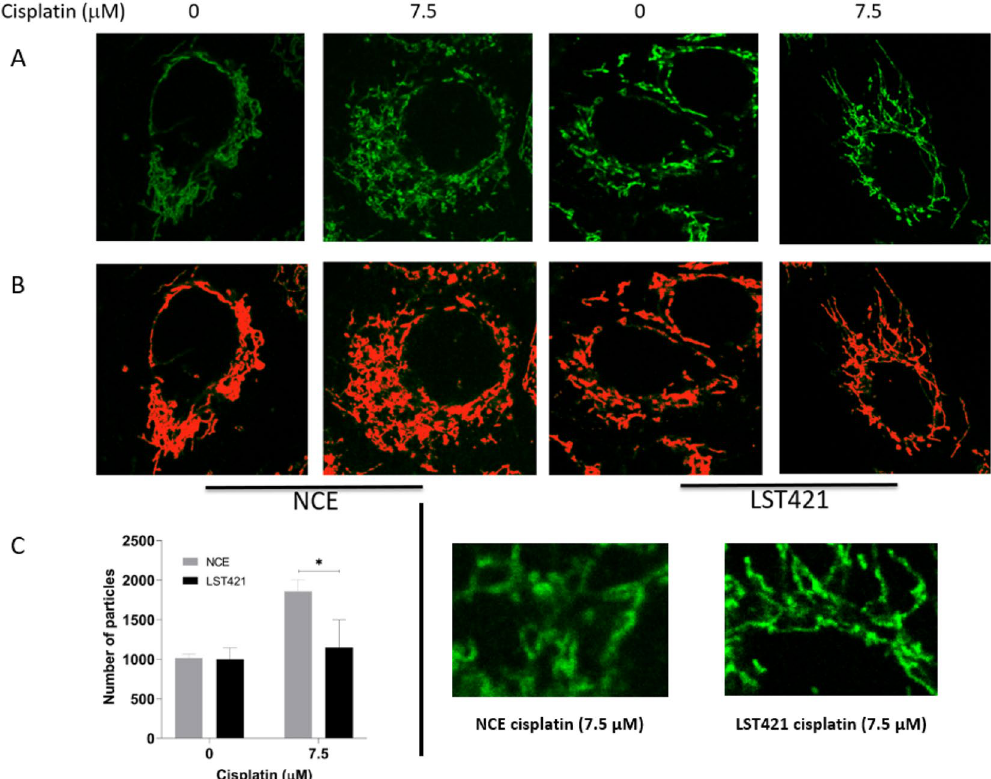
Figure 4. Cytoglobin protects cells from cisplatin (7.5 µM, 48 h) mediated fragmentation of mitochondria. Mitochondria were visualised by staining with mitotracker ( A ), magnified images of cisplatin treated NCE and LST421 cells are displayed in the bottom right of the figure. Threshold images were created in ImageJ ( B ) and used to quantify the number of mitochondria per cell ( C ). The results represent the mean of three independent fields of view ± SD (n = 3) with each field of view containing on average 5–10 cells. * Significantly differently from the un-transfected parent cell line, p <